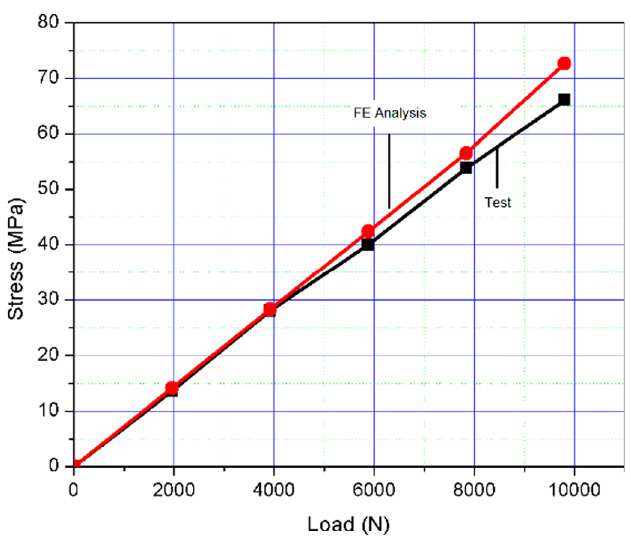
Fig. 7. Test & FE results at gauge-1 location.